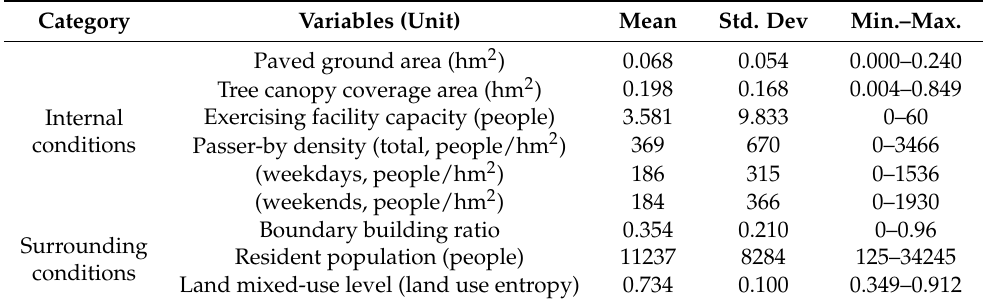
Table 3. Descriptive statistics of the independent